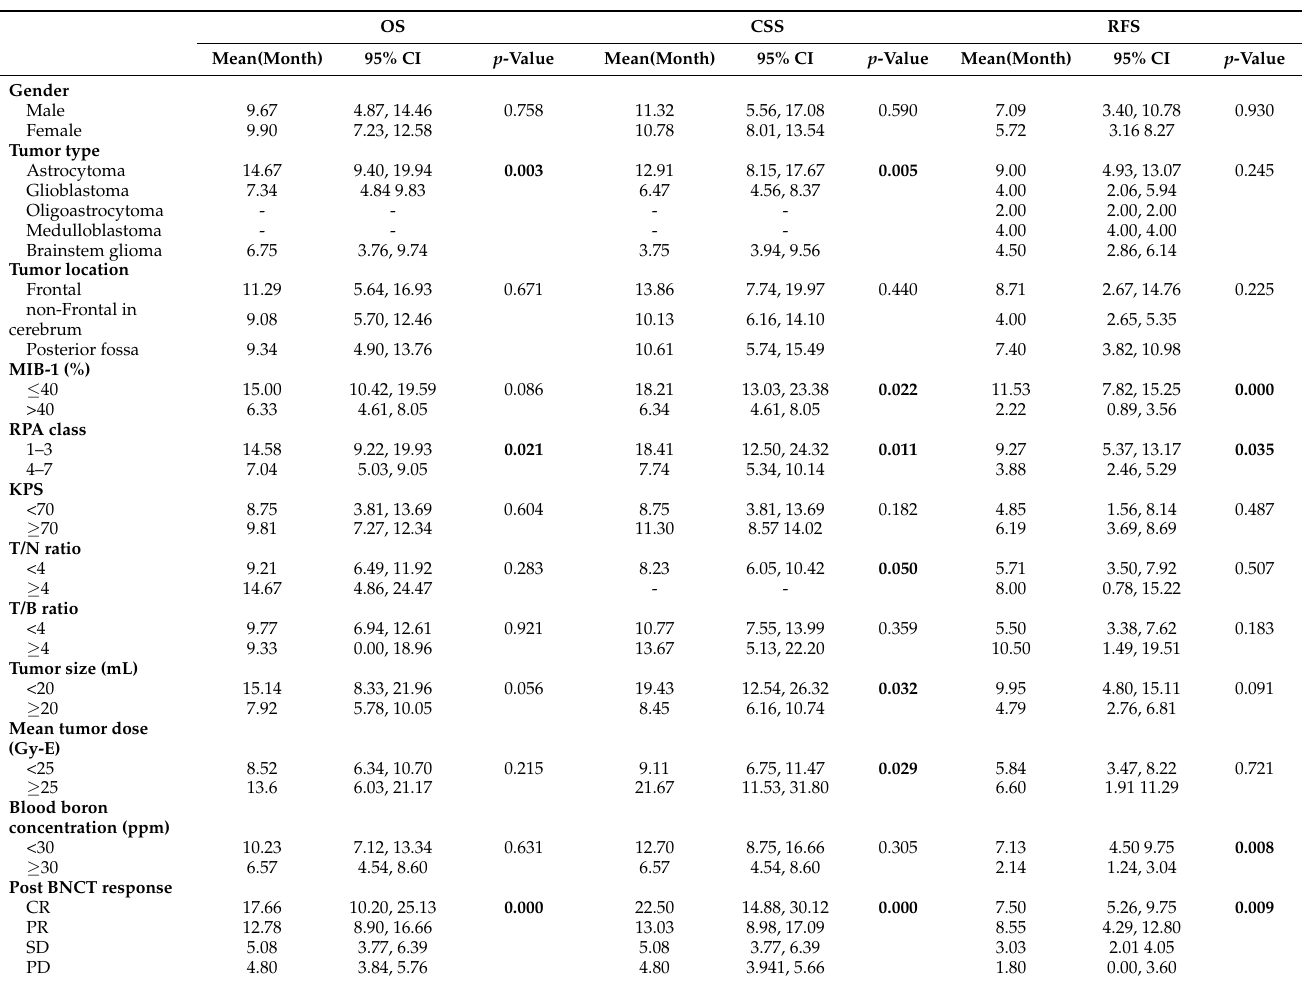
(Figure 4B) or receiving a mean tumor dose ≥ 25 Gy-E had better CSS (Figure 4C). The mean CSS values of patients with tumor volumes of <20 mL and ≥ 20 mL were 12.54 and 8.45 months, respectively ( p = 0.032). The mean CSS values of patients receiving <25 Gy-E and ≥ 25 Gy-E were 9.11 and 21.67 months, respectively ( p = 0.029). For these patients, who had immediately life-threatening conditions and complied with the Emergency and Compassionate Use standards, it is worth noting that receiving BNCT with a tumor dose ≥ 25 Gy-E greatly extended life by 21.67 months. Table 4. Overall survival, cancer specific survival, and relapse-free